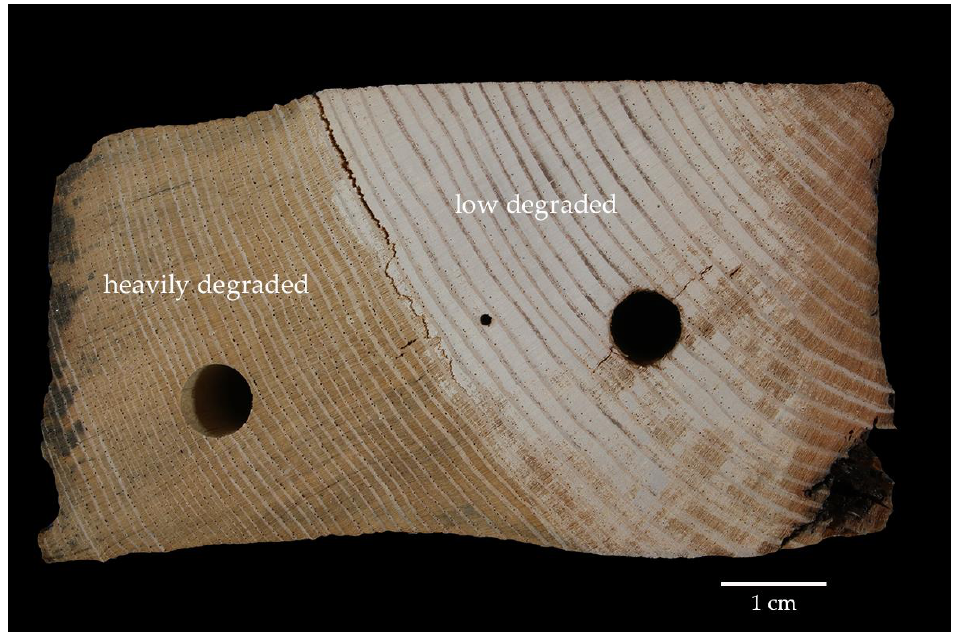
Figure 1. Air-dried reference sample. A top view of the cross section. Two different zones of the sample are visible indicating heavily degraded outer areas (hd) and low degraded inner areas (ld). Core samples were taken from both parts of the sample.